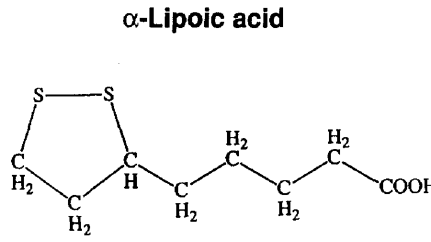
Figure 2. Chemical structure of α -Lipoic acid. Modified from [64].